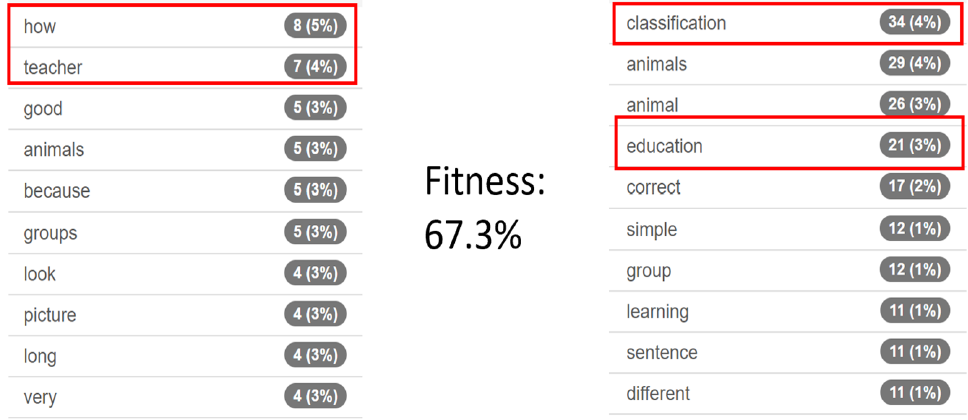
Figure 6. Flow chart of speech conversion text statistics for teaching status results.